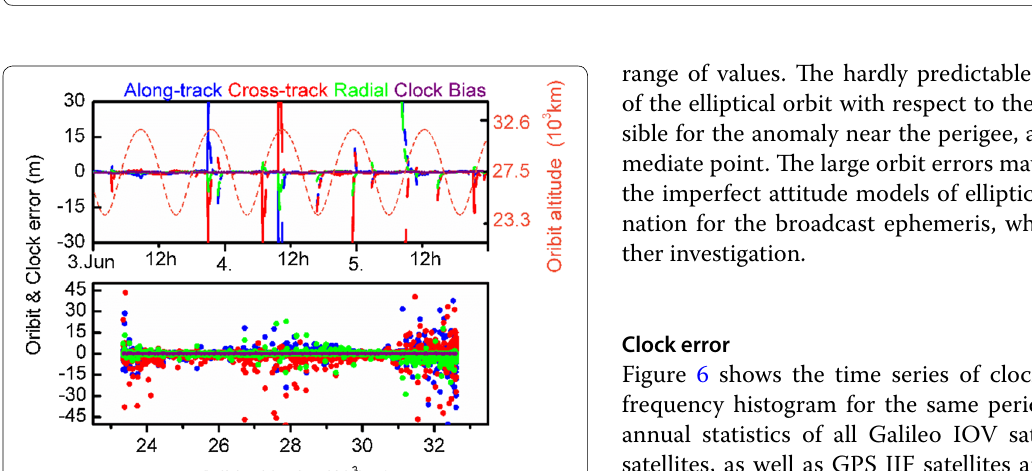
presented in Fig. 5 (bottom). When the satellite passes through the perigee, apogee or the intermediate point, the orbit errors in the three components reach a maxi- mum of tens of meters with a few exceptions, while the clock biases are not affected and remain within a small